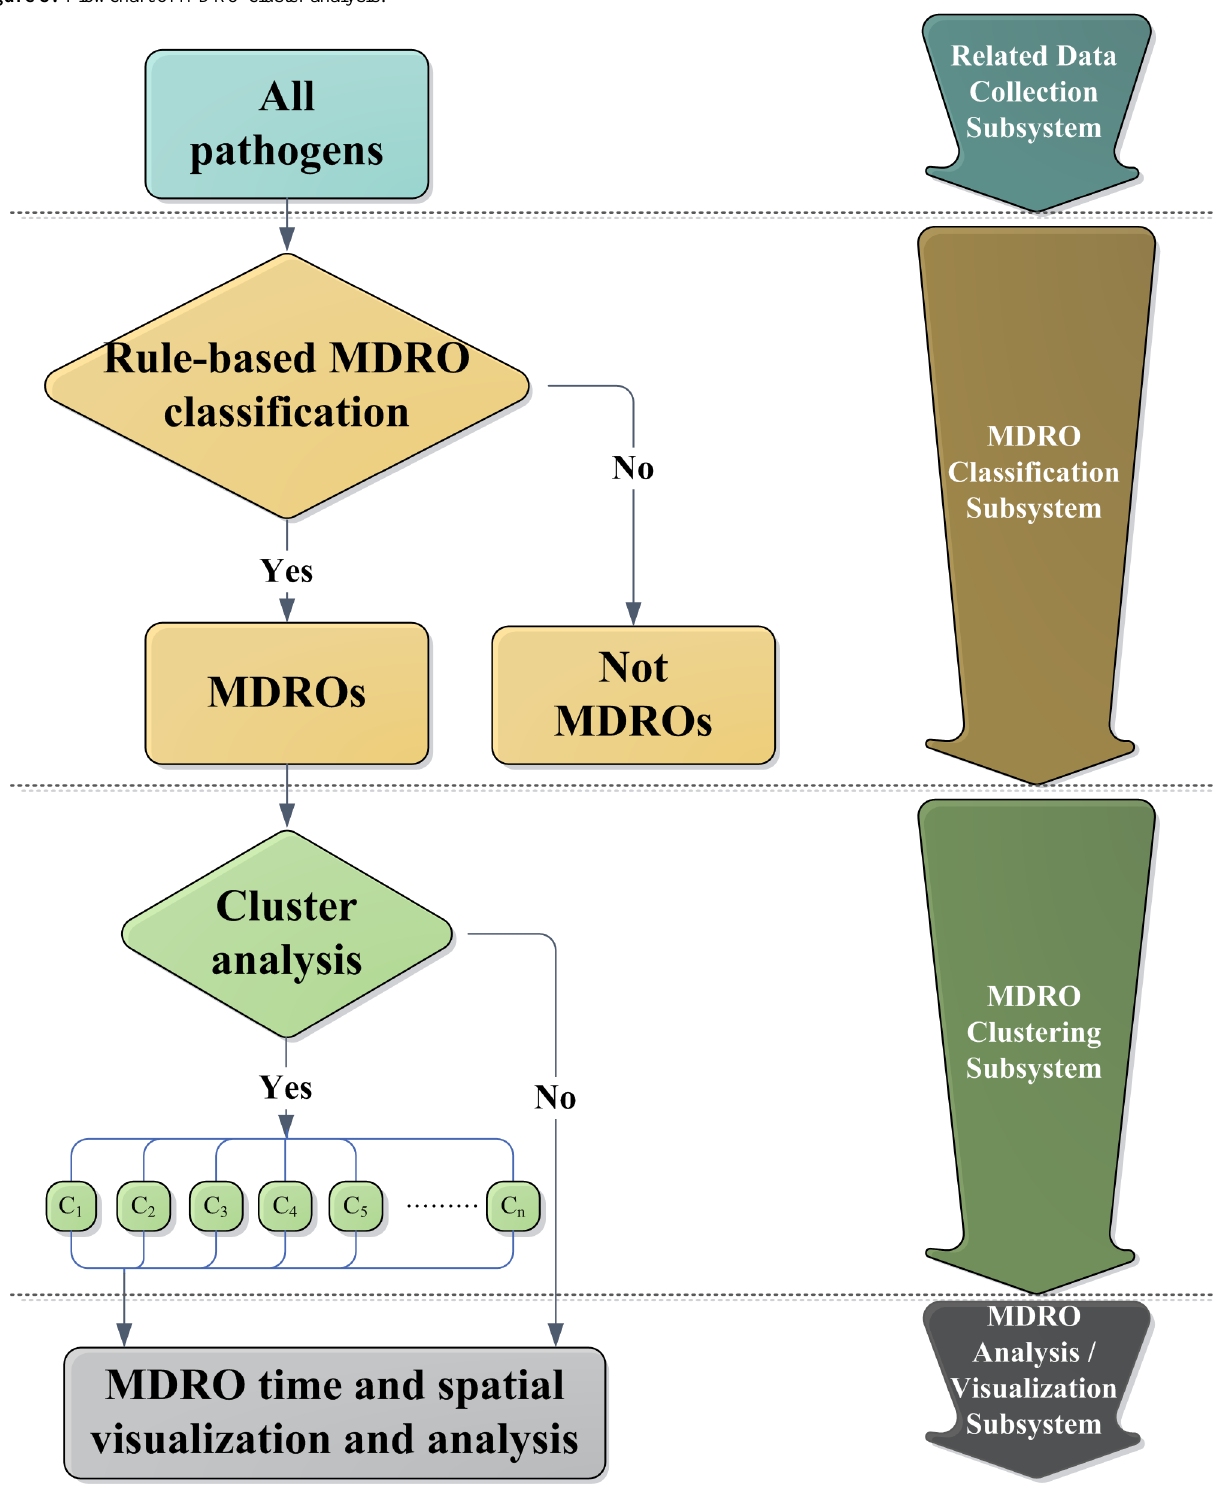
Figure 5. Flowchart of MDRO cluster